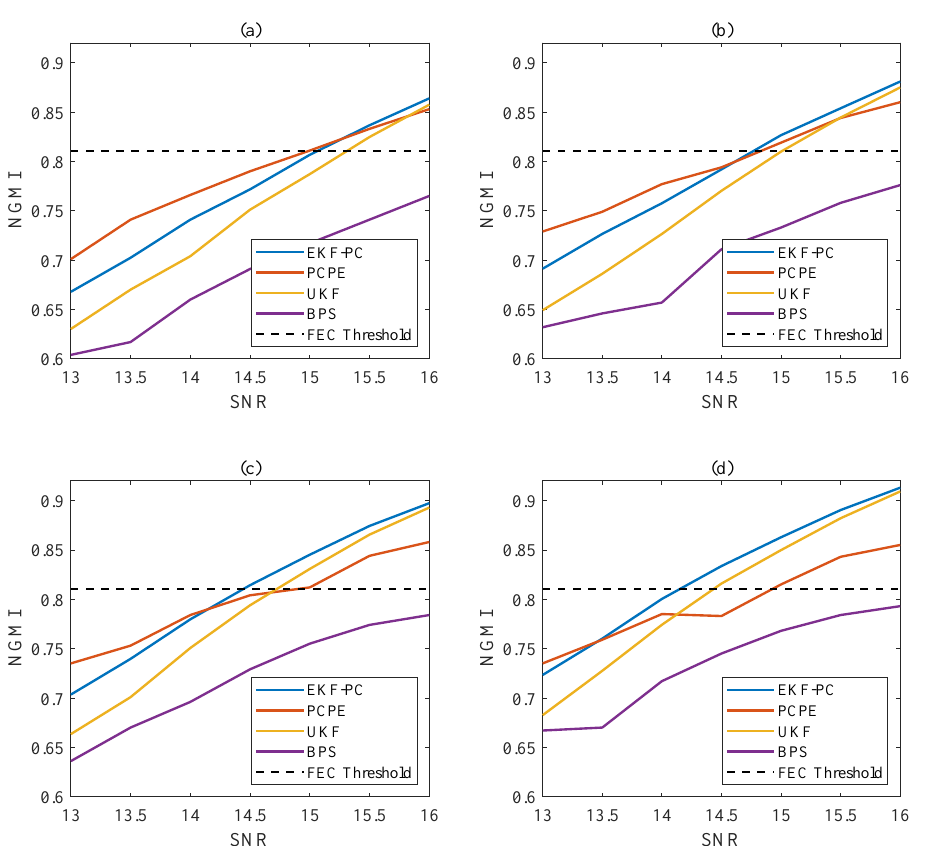
Figure 8. NGMI performance of the B2B transmission with variable SFs: ( a ) SF = 0.02, ( b ) SF = 0.025, ( c ) SF = 0.03, and ( d ) SF =